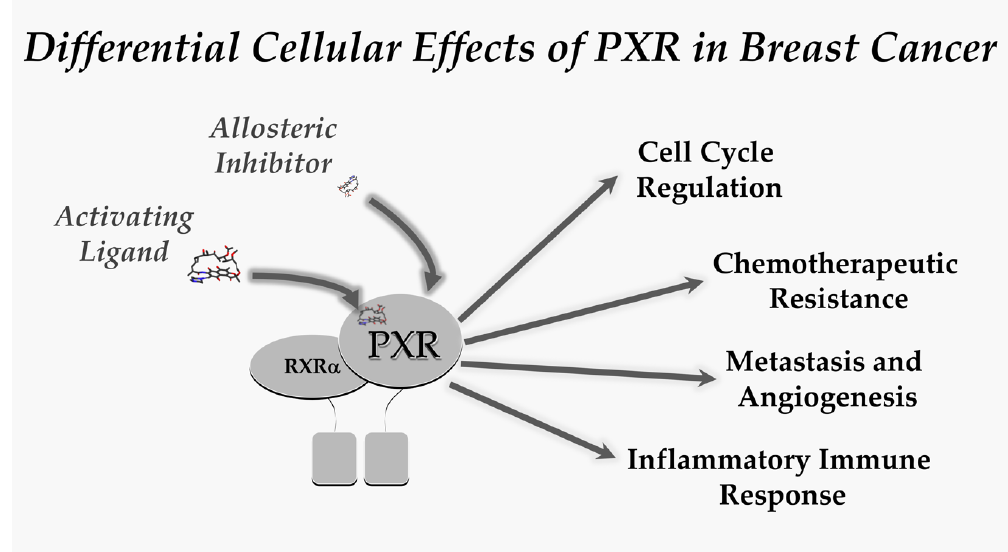
Figure 1. The scheme depicts the pharmacological tools available to examine the therapeutic potential that exists in the field of PXR-mediated modification of breast cancer initiation, progression and metastases. We believe that this represents an important and exciting opportunity to move this field forward.